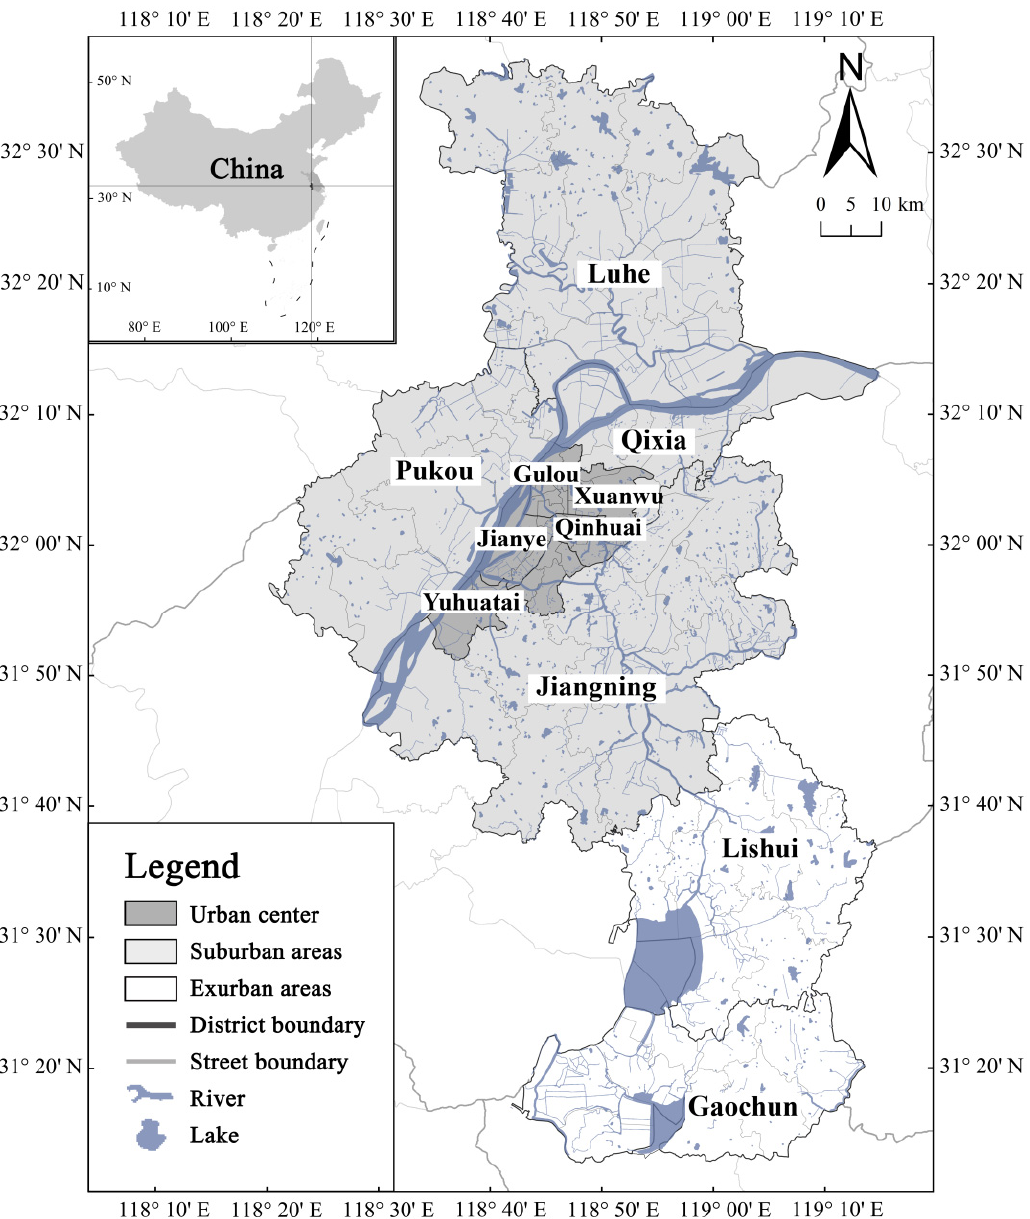
Figure 2. Nanjing